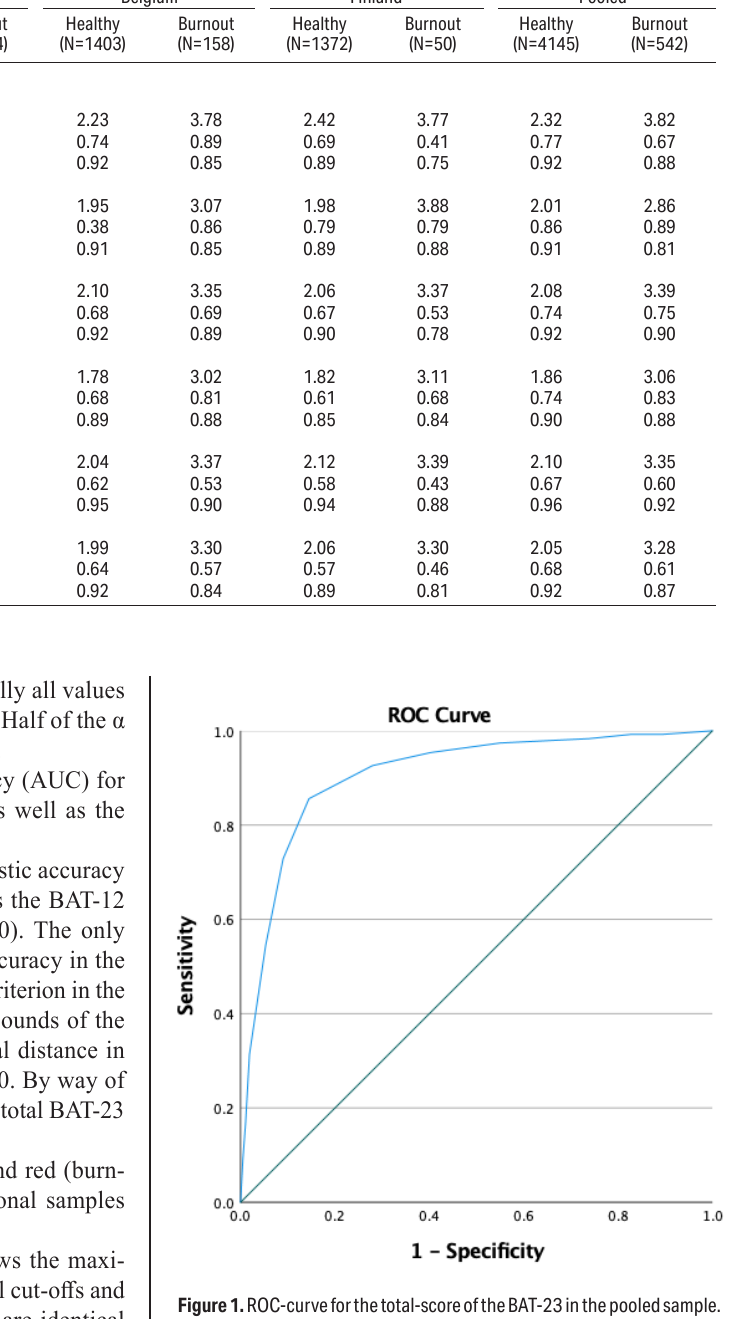
Figure 1. ROC-curve for the total-score of the BAT-23 in the pooled sample. Diagonal segments are produced by